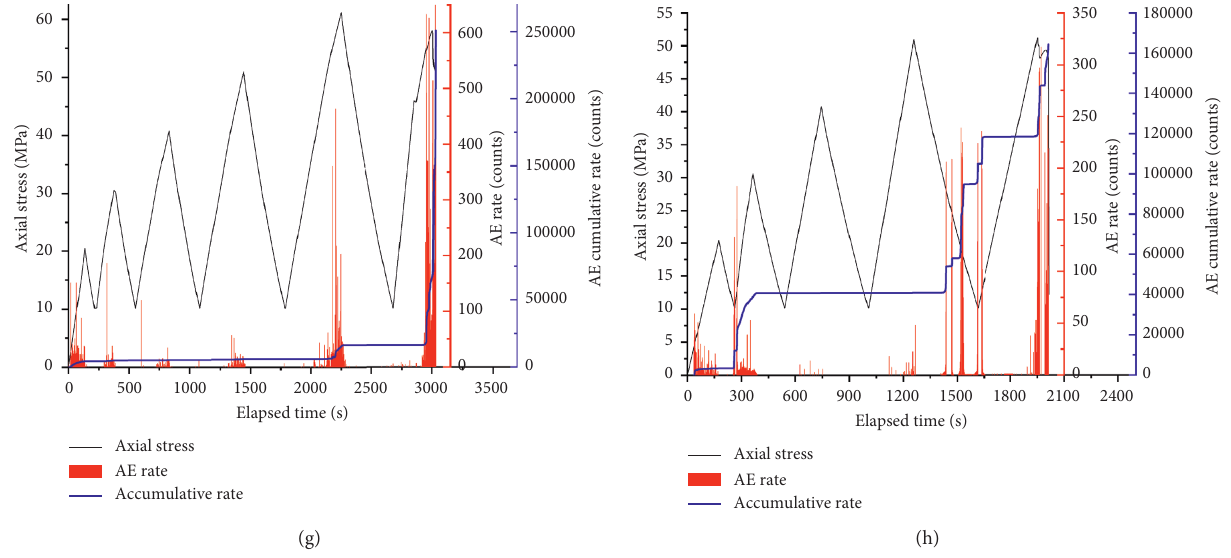
Figure 10: The counting rate of rock samples subjected to different stress paths: (a) NF1; (b) FT1-3; (c) NF2; (d) FT2; (e) NF3; (f) FT3; (g) NF4; (h)